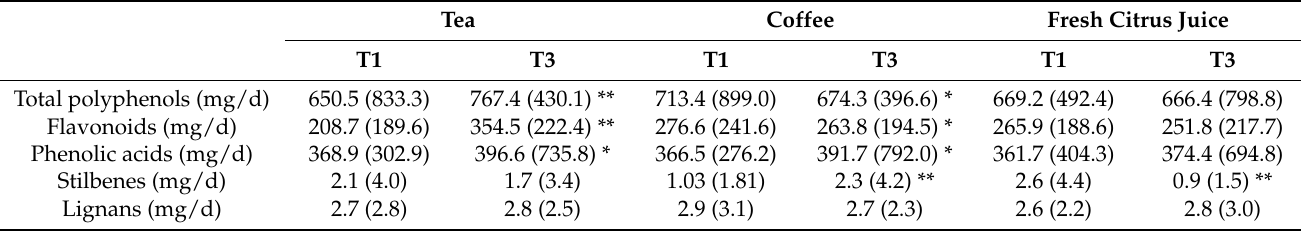
Table 3. Total and main classes of dietary polyphenols by consumption of polyphenol-rich beverages. Tea Coffee Fresh Citrus Juice T1